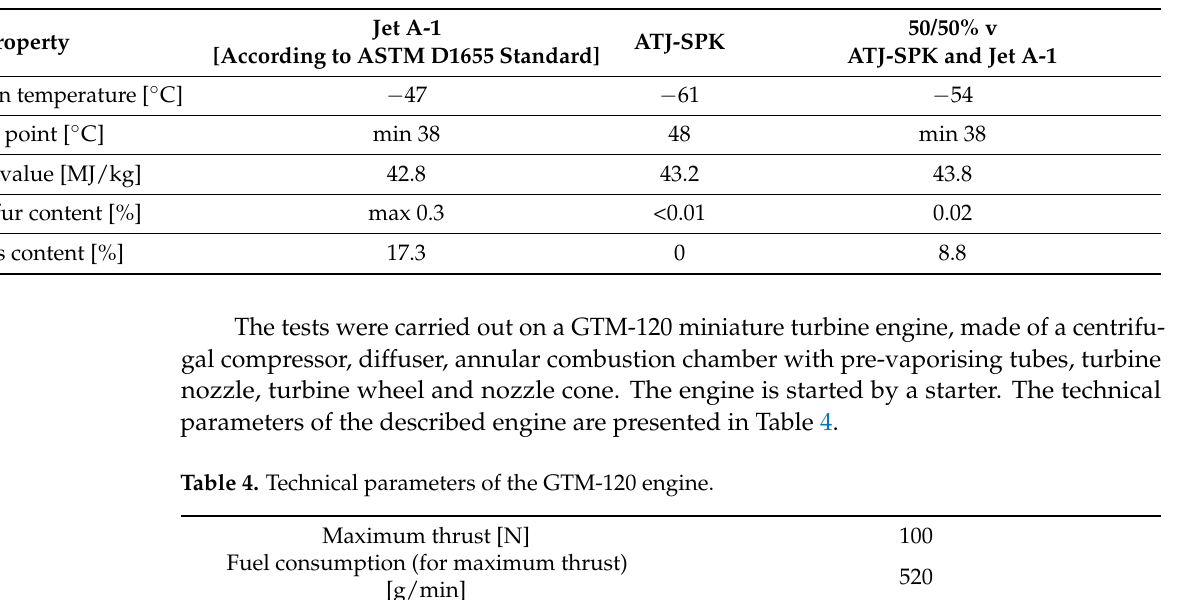
Table 3. Physicochemical properties of tested fuels [own study based on [31,32].